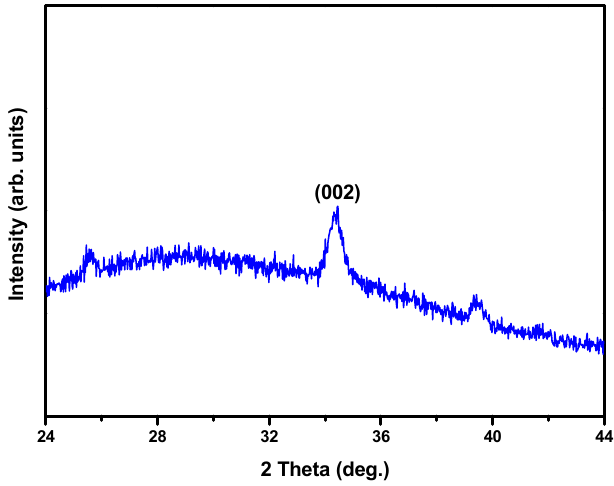
Figure 3. X-ray diffraction (XRD) pattern of the ZnO seed layer. Materials 2021 , 14 , x FOR PEER REVIEW